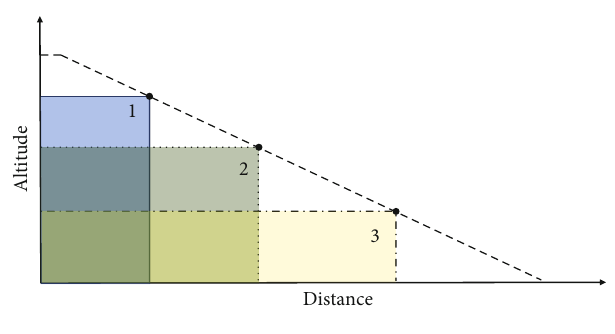
Figure 4: Design fl ow.